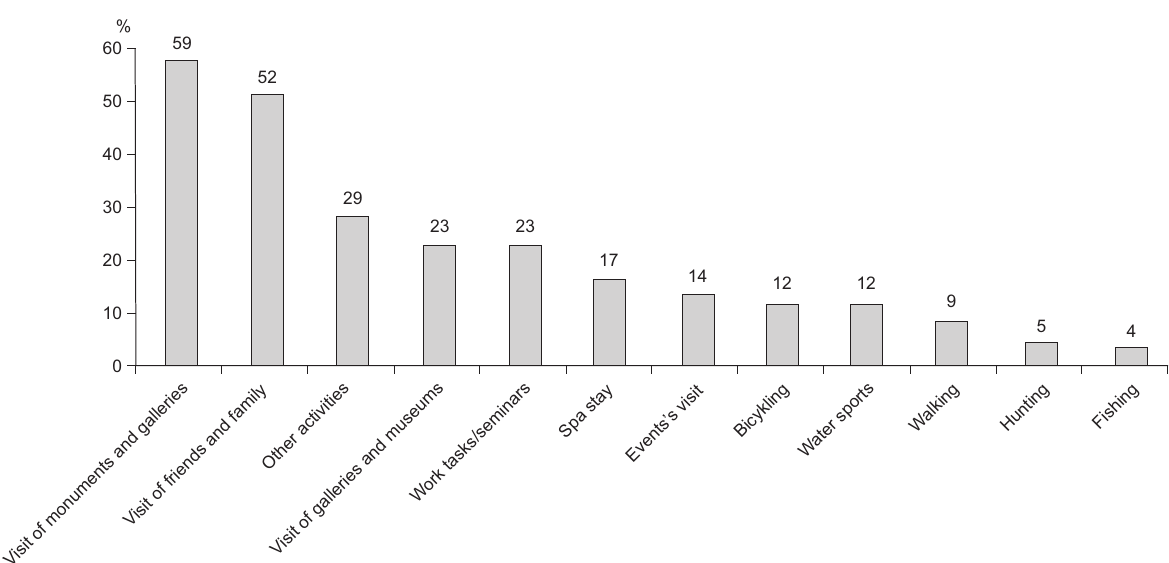
Fig. 3. Activities during a tourist visit in the Banská Bystrica Region. Source: own research.